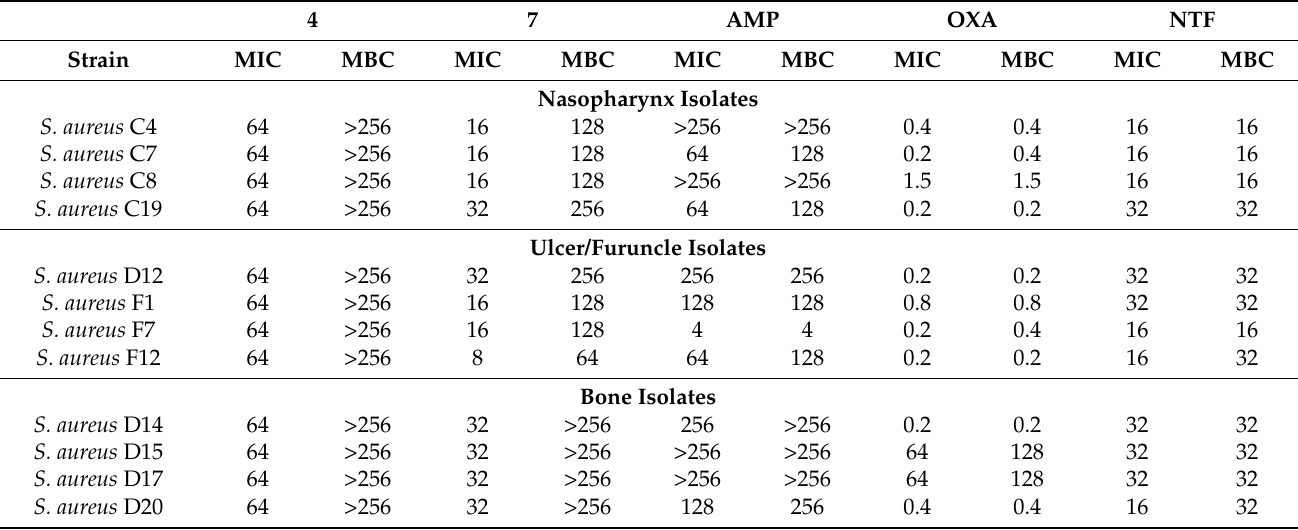
Table 3. In vitro activity of 4 and 7 against clinical isolates of S. aureus expressed as the minimal inhibitory concentra- tion (MIC) ( µ g/mL) and minimal bactericidal concentration (MBC) ( µ g/mL). AMP: ampicillin, OXA: oxacillin, NTF: nitrofurantoin.